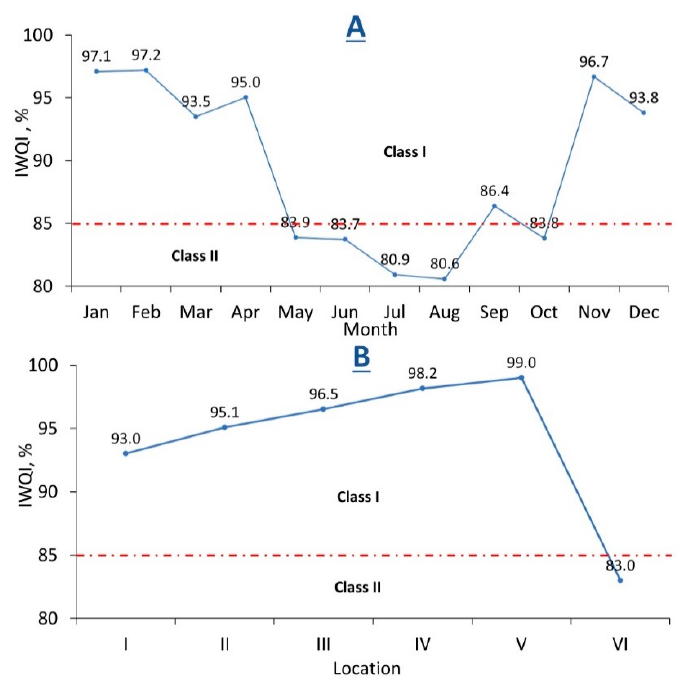
Figure 7. Temporal ( A ) and spatial variations ( B ) in the irrigation water quality index (IWQI) of the Bahr Mouise canal.